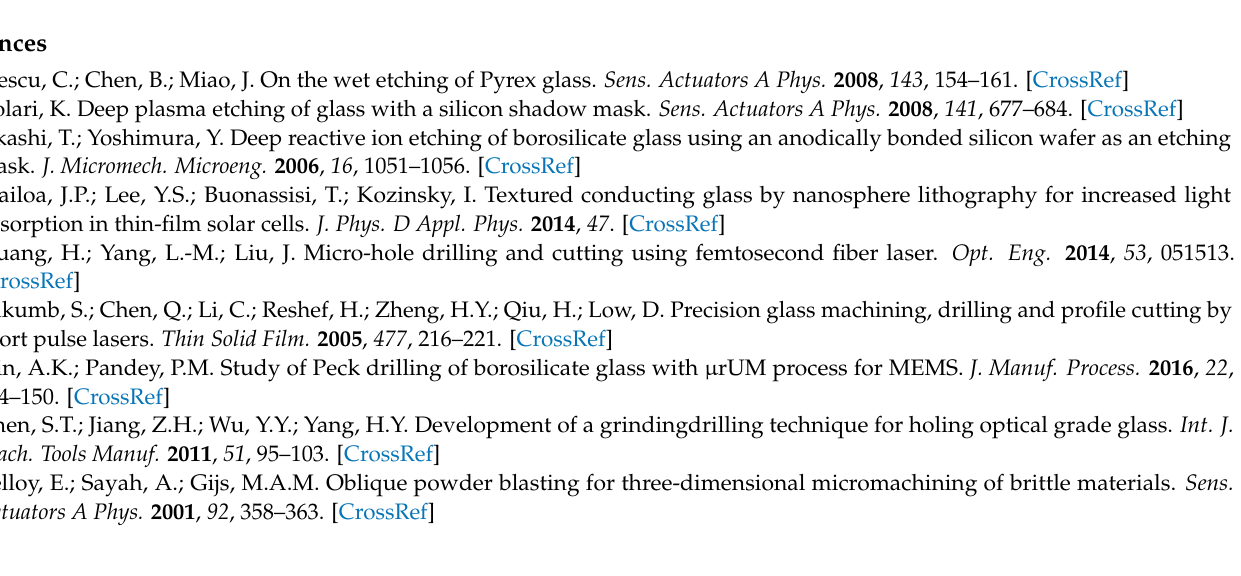
Table S2: Summary of studies on micro/nano glass molding with Ni-alloy molds, Table S3: Summary of studies on micro/nano glass molding with SiC molds, Table S4: Examples of studies on micro/nano glass molding with WC molds, Table S5: Summary of studies of GC micro/nano mold insert systems for glass imprinting, Table S6: Summary of studies on other micro/nano mold insert systems for glass